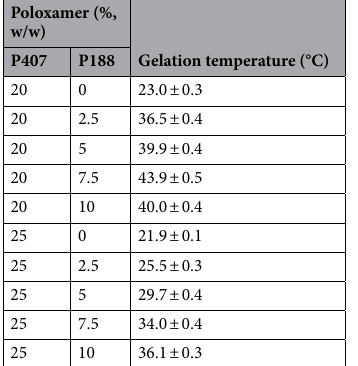
Table 1. Gelation temperature of gel at different concentration of P407 and P188.